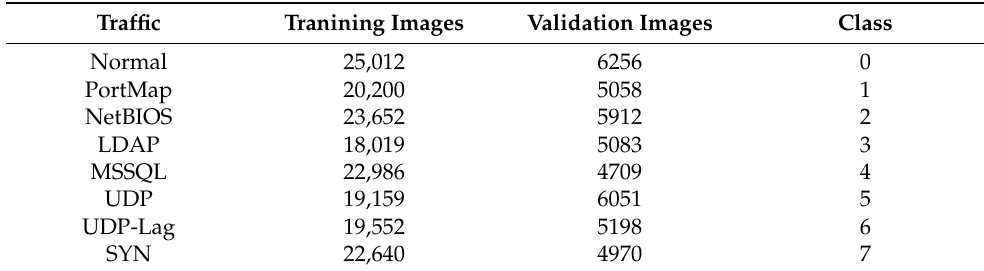
Table 9. Training and Validation Set